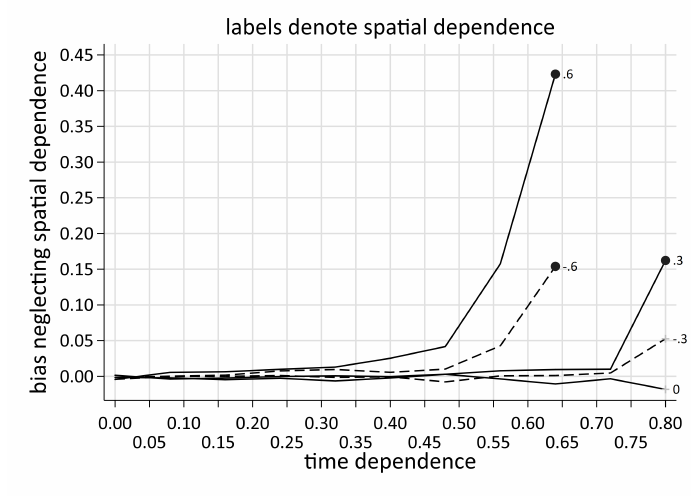
Figure E.2: Bias of Team Dynamic neglecting the spatial dimension, but applying a spatial lag of X specification. The vertical axis describes γ TD − γ 0 , the horizontal axis depicts γ 0 . Labels denote spatial dependence in the DGP ( λ 0